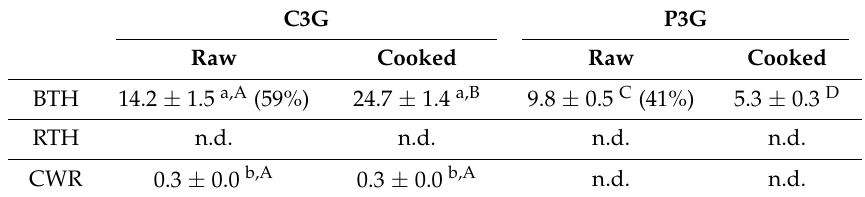
Table 4. Anthocyanin content (mg/100 g d.m.) in raw and cooked Thai and wild rice samples. C3G P3G Raw Cooked Raw Cooked